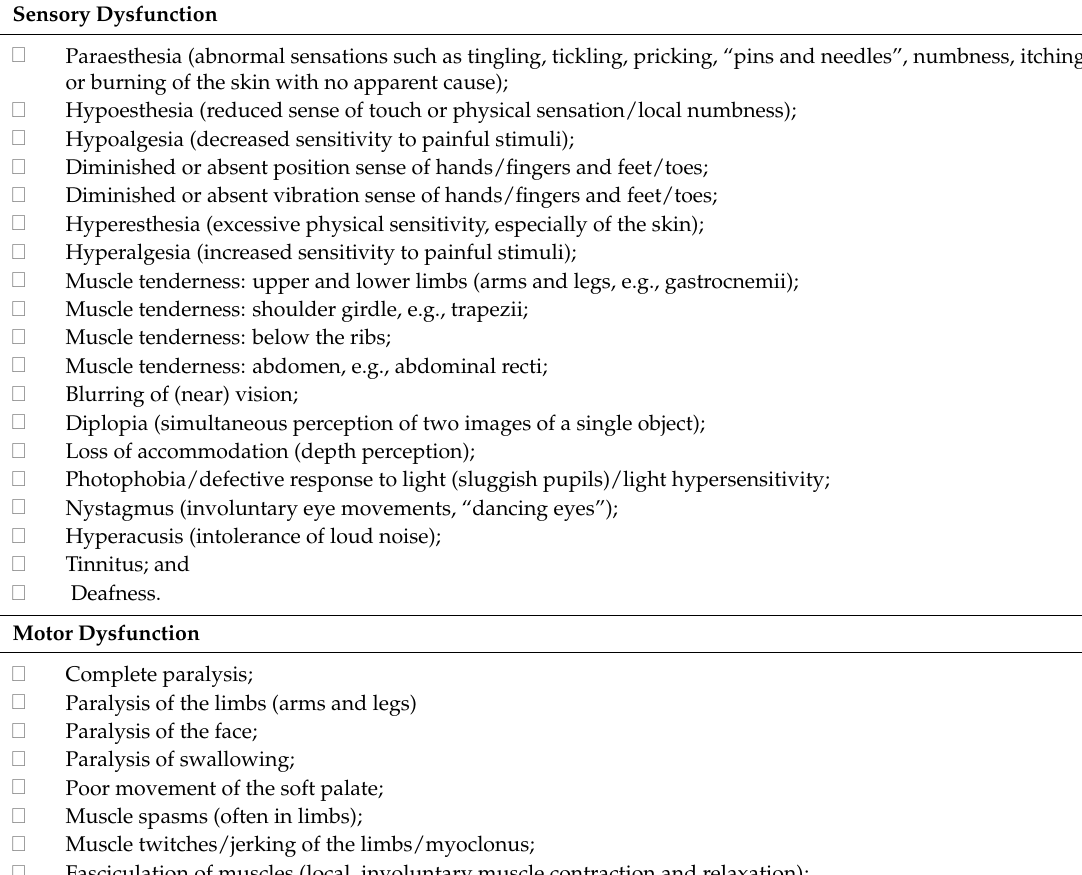
Table 3. Neurological symptoms of patients observed in endemic and epidemic cases [1,3]. Cognitive Dysfunction